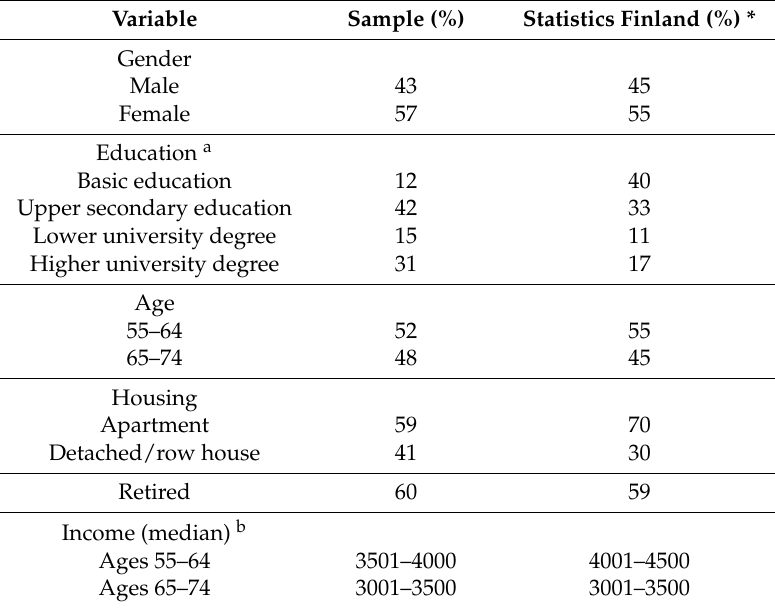
Table 1. The sociodemographic factors of respondents ( n =